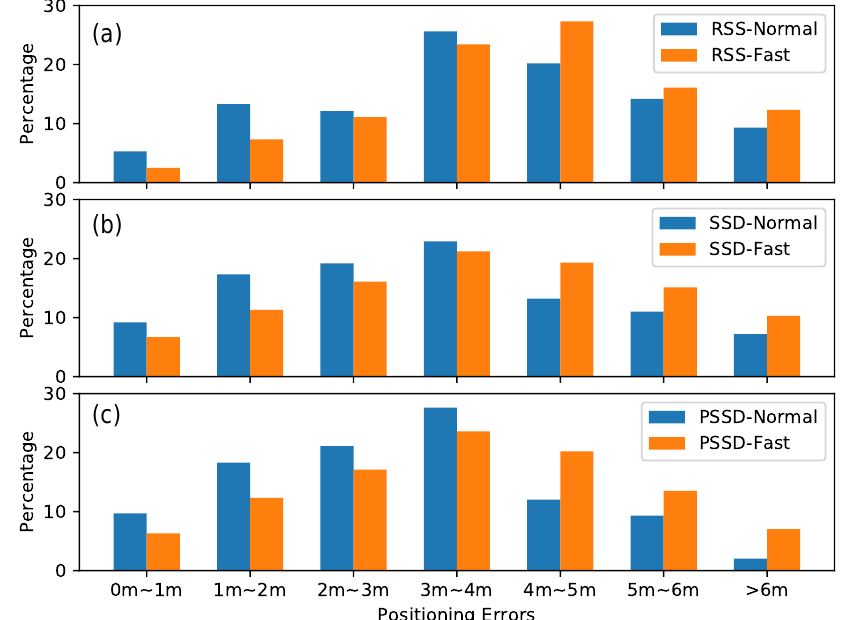
Figure 14. The probability distribution of positioning errors, denoting the walking speed influence on localization performance of given approach for heterogenous devices. The positioning errors have been classified into 7 levels: 0 ∼ 1 m, 1 ∼ 2 m, 2 ∼ 3 m, 3 ∼ 4 m, 4 ∼ 5 m, 5 ∼ 6 m and > 6 m. ( a ), ( b ) and ( c ) denote the RSS, SSD and PSSD performances, respectively.